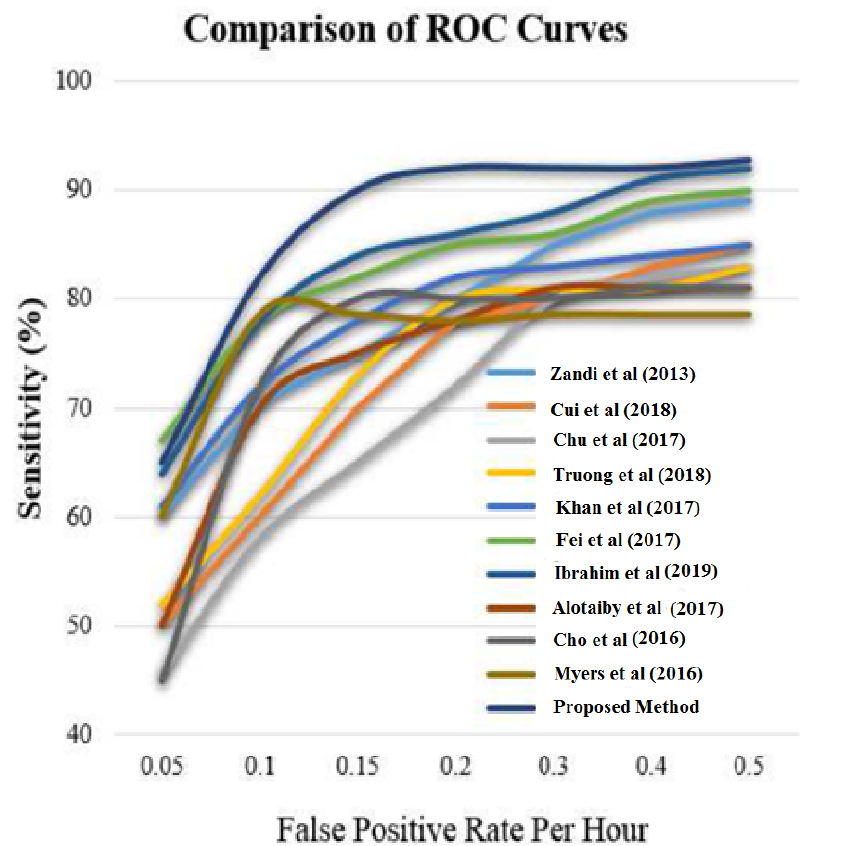
Figure 6. Analysis of ROC curves with existing methods